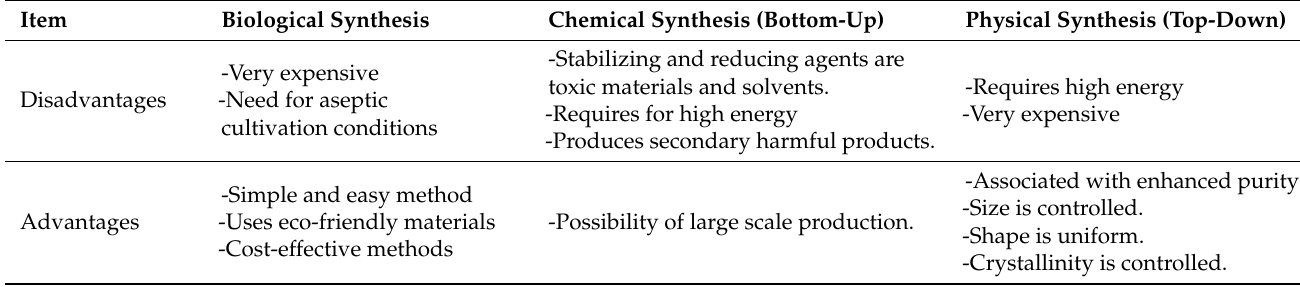
Figure 2. Difference between bottom-up and top-down methods used for the synthesis of NMs. Copied from MDPI [19]. Table 1. Comparison of different approaches for the synthesis of nanomaterials.